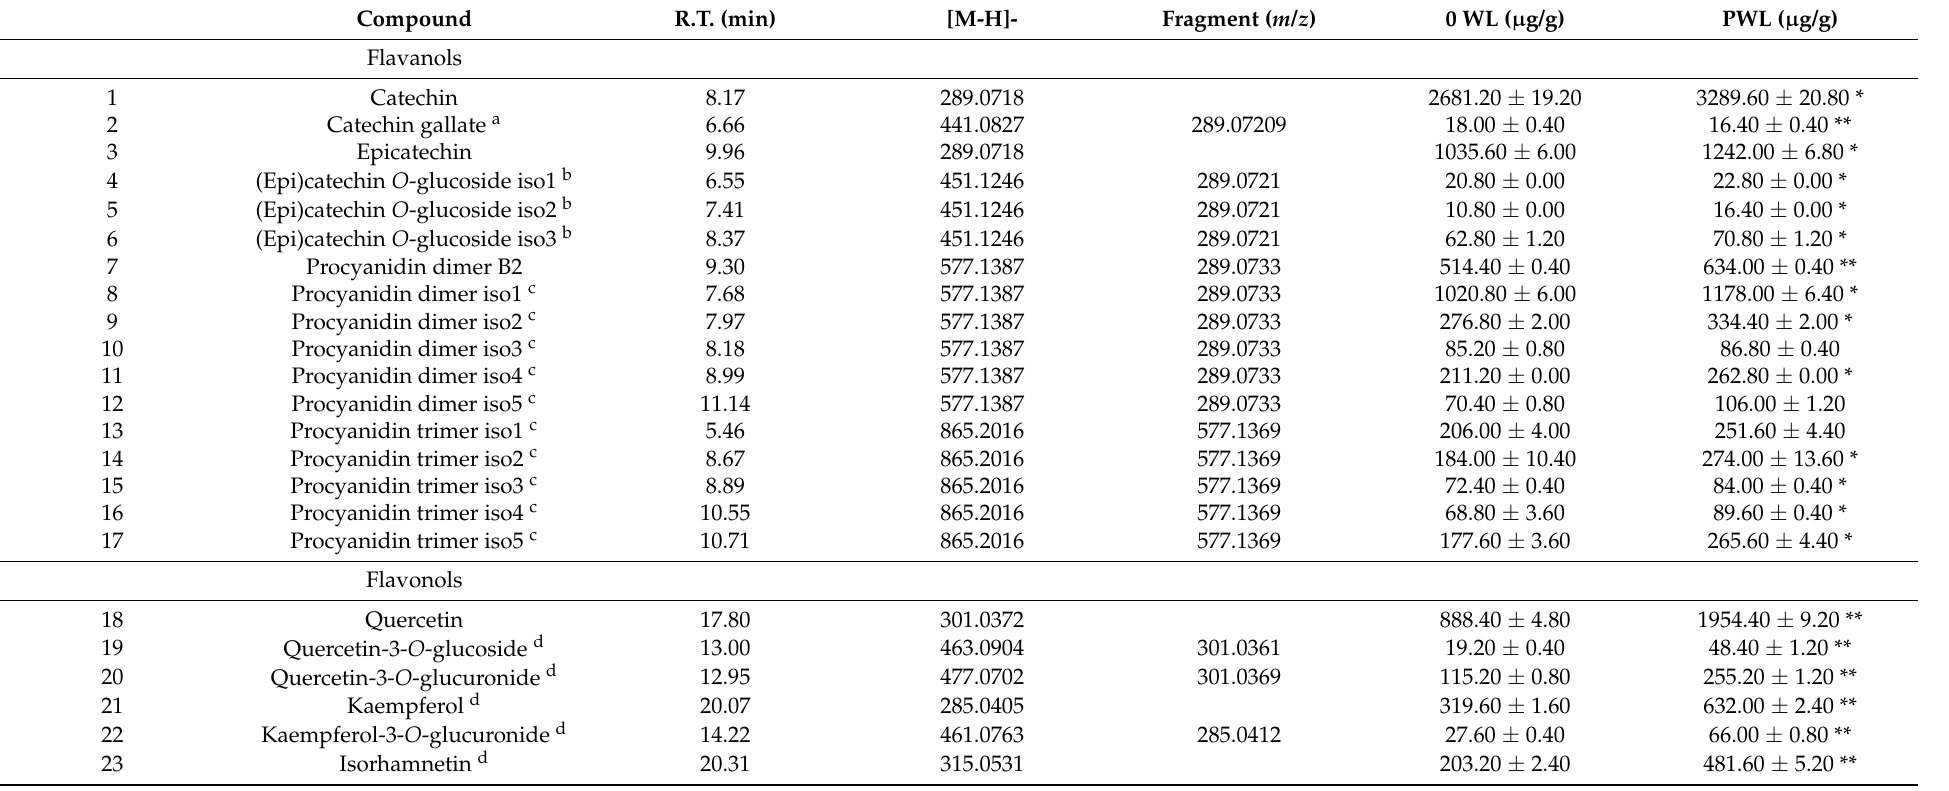
Table 2. Non-anthocyanin characterization by UHPLC-(ESI-)-Q-TOF-MS in 0 WL and